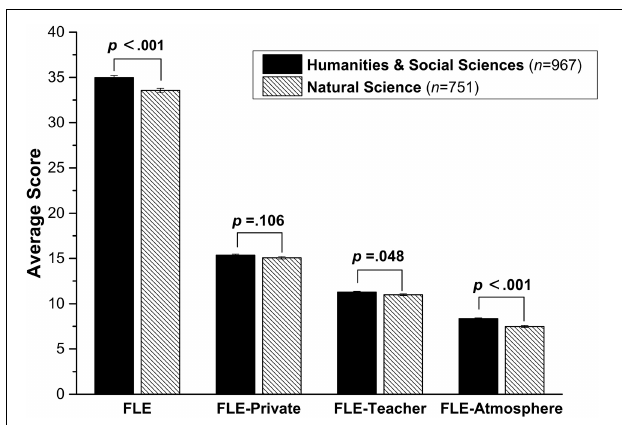
FIGURE 2 | Disciplinary differences in foreign language enjoyment (Error bars represent standard errors).